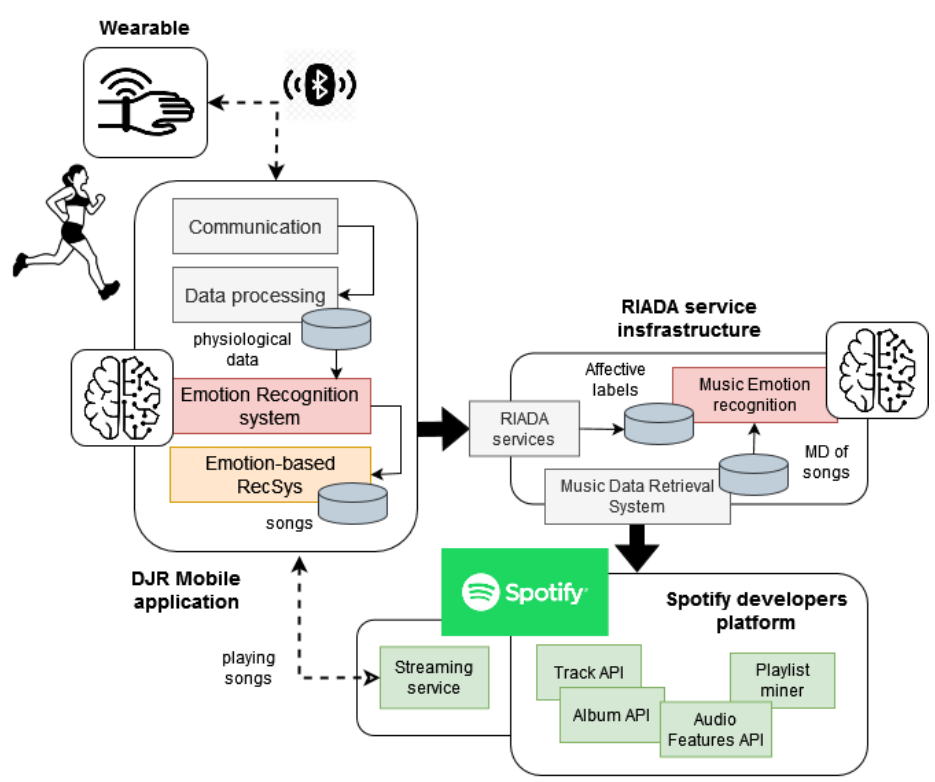
Figure 4. Technological components involved in the DJ-Running